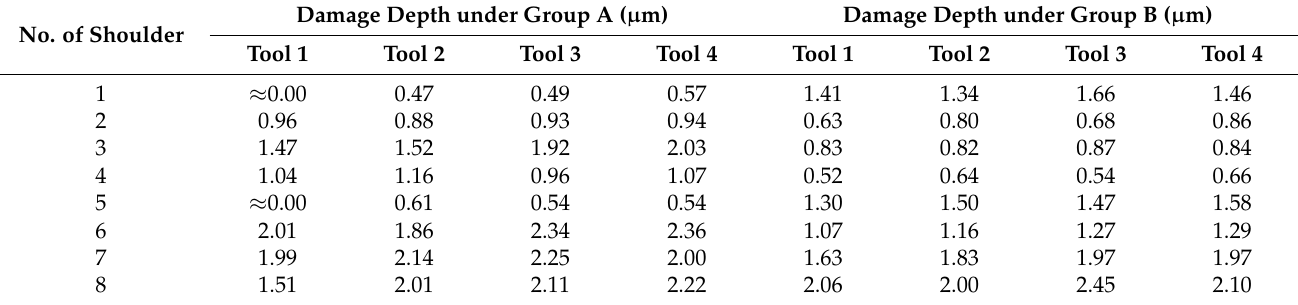
Figure 5. Damage morphologies in shoulders ( a ) 3 and ( b ) 5 cut by tool 1 under group A; ( c ) repre- sentative profiles from ( a ); ( d ) maximum damage depths for ten profiles shown. Table 3. Measured shoulder damage depths for each shoulder. Table 3. Measured shoulder damage depths for each shoulder.